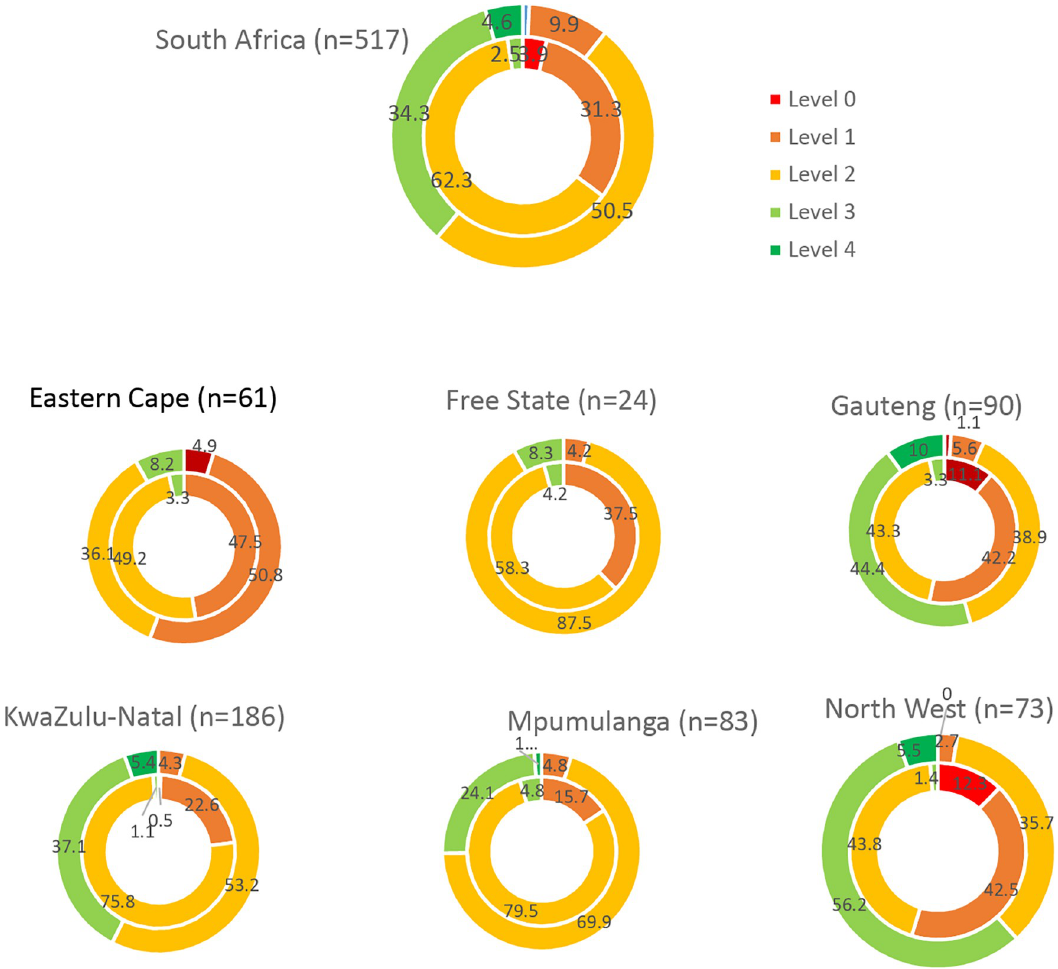
Fig 4. Distribution of implementation levels by assessment round (inner circle—Round 1; outer circle: Round 2) and province, SPI-RT assessment, 2015–2017, South Africa.